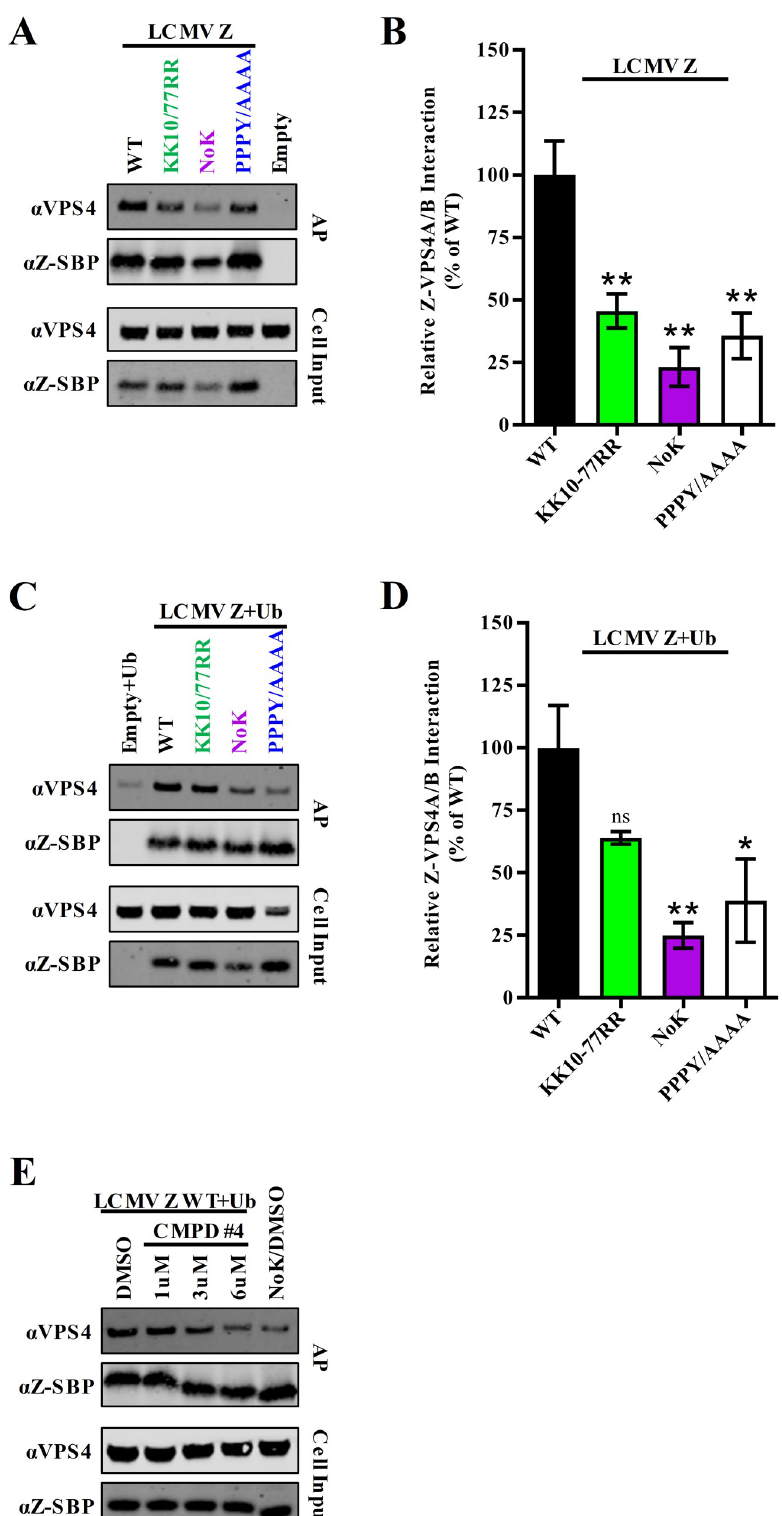
Fig 7. Efficient interaction of LCMV Z with the ESCRT protein VPS4 requires residues K10, K77, and the PPXY late domain. (A-B) HEK293T cells were transfected with an empty vector or a vector encoding SBP-tagged LCMV